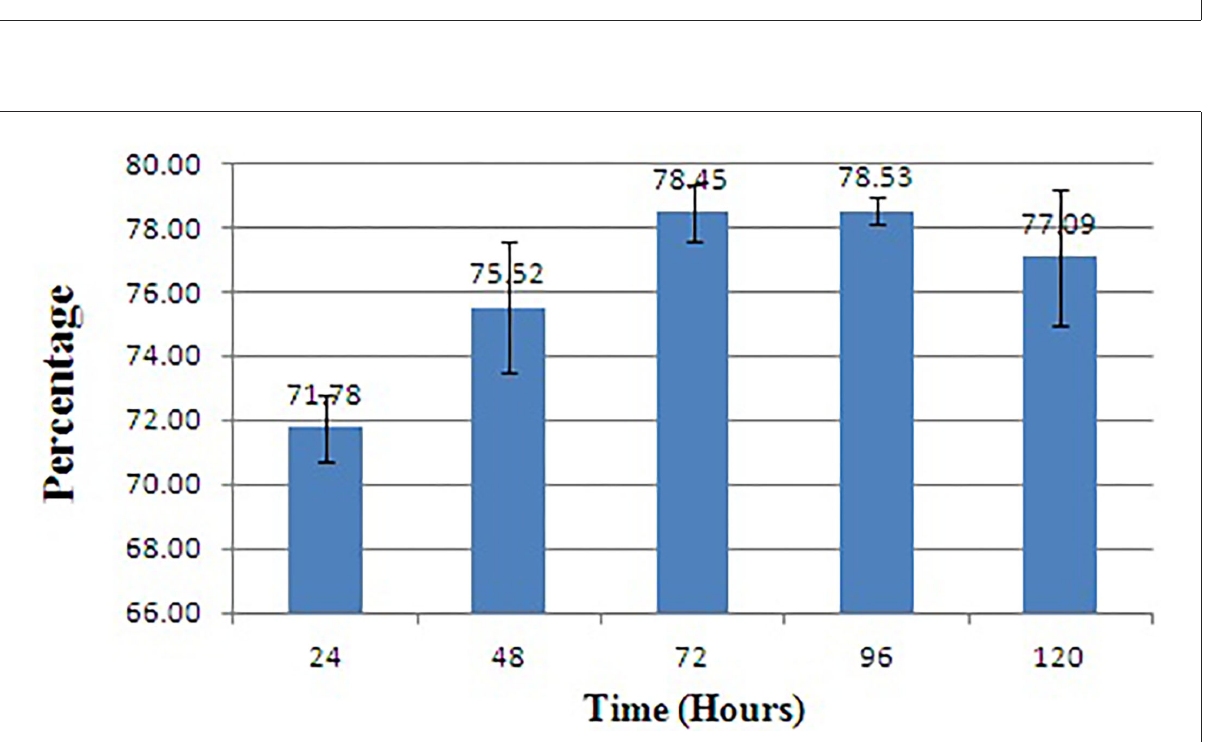
FIGURE6 Effect of crude extract on swarming motility of Pseudomonas aeruginosa MTCC2297; (A) P. aeruginosa 2,297 alone, (B) P. aeruginosa 2,297 + DMSO (Control), and (C) Ethyl acetate extract of RB isolate (200 µ l).